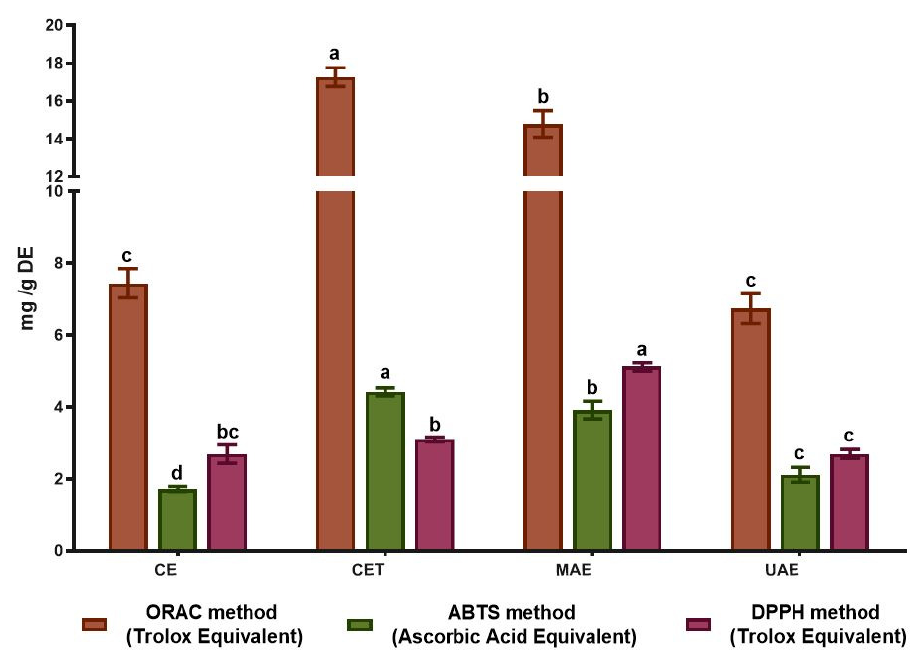
Figure 1. Antioxidant activity of different Bravo de Esmolfe apple extracts by ORAC method (ex- pressed as mg TE/g DE), ABTS method (expressed as mg AAE/g DE) and DPPH method (expressed as mg TE/g DE). Different letters (a, b, c, d) mean significant differences between extraction tech- niques in each antioxidant assay (same color in the graph), determined by Tukey’s post-hoc test ( p < 0.05).